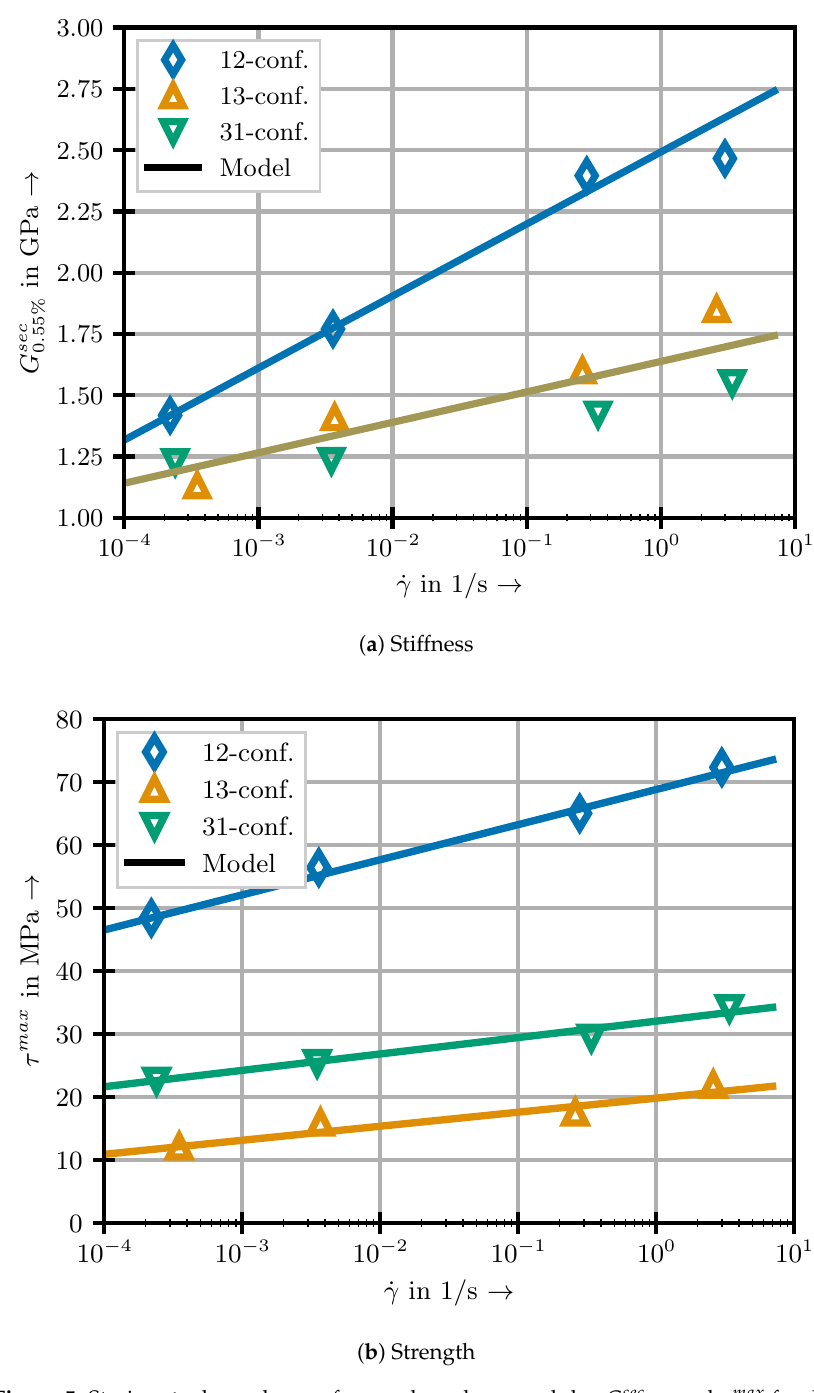
Figure 5. Strain rate dependency of exemplary shear modulus G sec